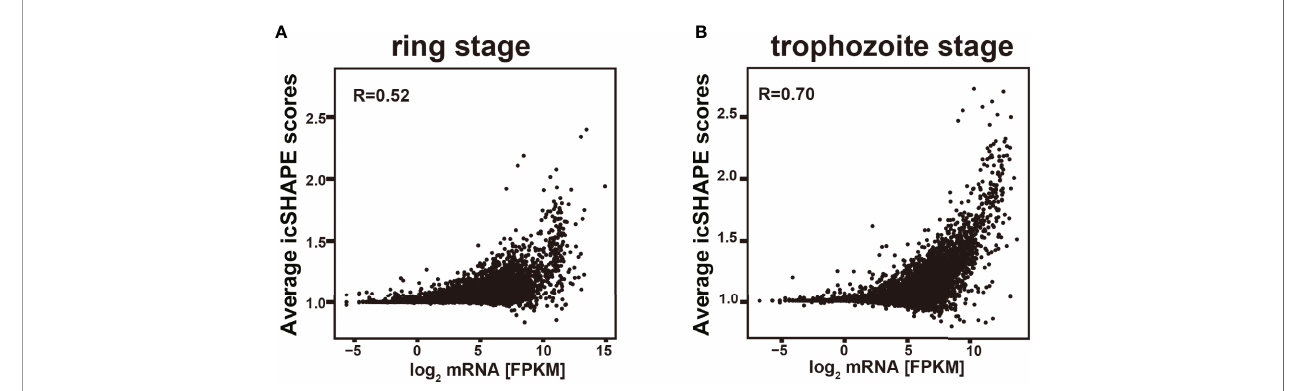
FIGURE 5 | Relationship of icSHAPE and expression abundant (FPKM) from RNA-seq analysis. Comparison of the average icSHAPE scores over the whole transcripts CDS regions revealed a clear correlation with the mRNA abundance. Dependence of the average icSHAPE scores on the mRNA abundance of the whole transcripts from ring stage at 37 degree (A) , and also the trophozoite stage at 37 degree (B) . Pearson correlation coef fi cient (R) is showed in